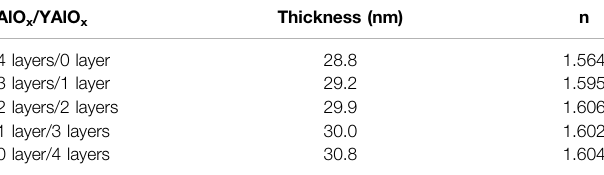
TABLE 2 | Thicknesses of the AlO x /YAlO x bilayer dielectrics. AlO x /YAlO x